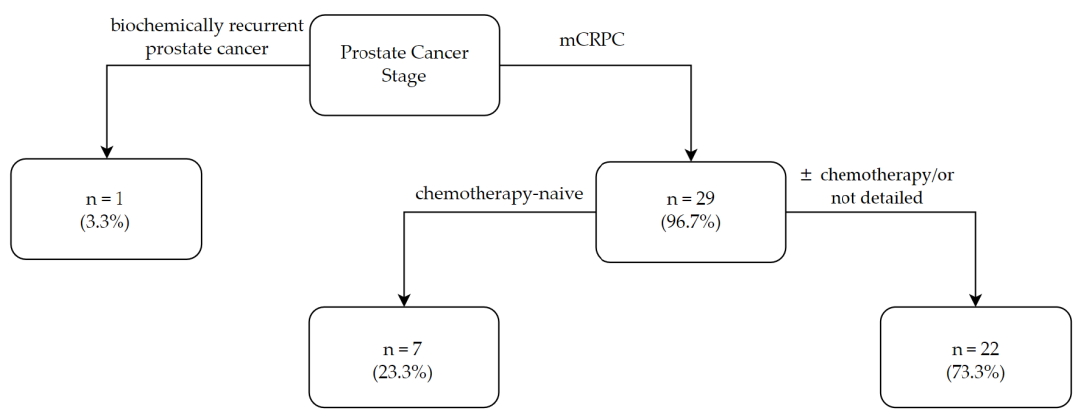
Figure 3. Prostate cancer stage of patients of LDMC studies. mCRPC: metastatic castration-resistant prostate cancer.